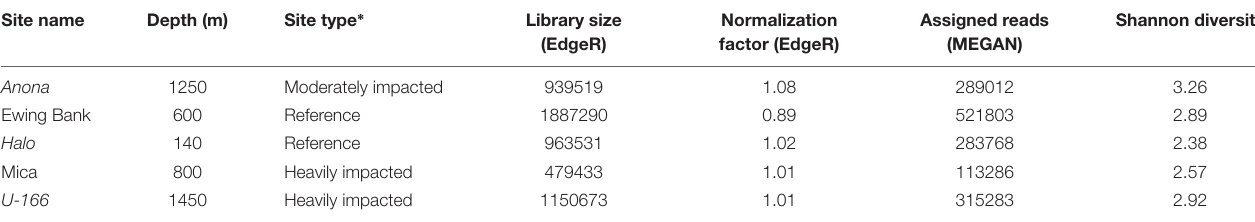
TABLE 2 | Descriptive statistics for metagenomes of biofilm